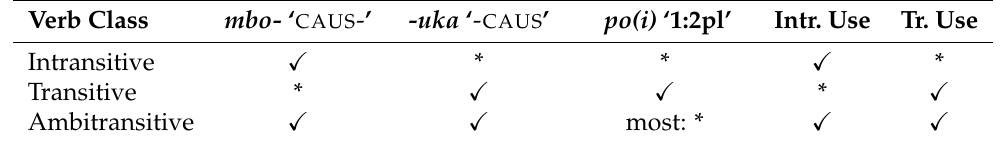
Table 2. Verb classes in Paraguayan Guaraní. A checkmark ‘ (cid:88) ’ means that the combination tends to be judged to be acceptable, an asterisk ‘*’ that it tends to be judged to be